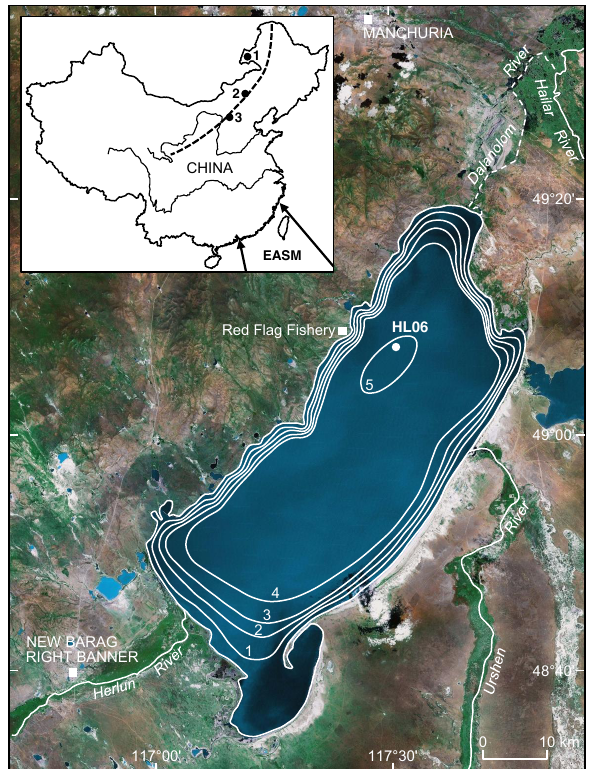
Figure 1. Map of Hulun Lake (from https://www.arcgis.com/home/ item.html?id=474c65ab3e1941468511785495eb8987, last access: 6 June 2018) showing the location of the HL06 core. A bathy- metric survey of the lake was conducted in July 2005 with an FE- 606 Furuno echo sounder (contours in meters). The inset gives a sketch map of China showing the current northern limit of the East Asian summer monsoon (dashed line) defined as the 400mm iso- hyet of mean annual precipitation (Chinese Academy of Sciences, 1984; Zhang and Lin, 1985) and the locations of the lakes (solid circles) mentioned in the present study. (1) Hulun Lake; (2) Dali Lake; (3) Daihai Lake. EASM in the inset indicates the East Asian summer